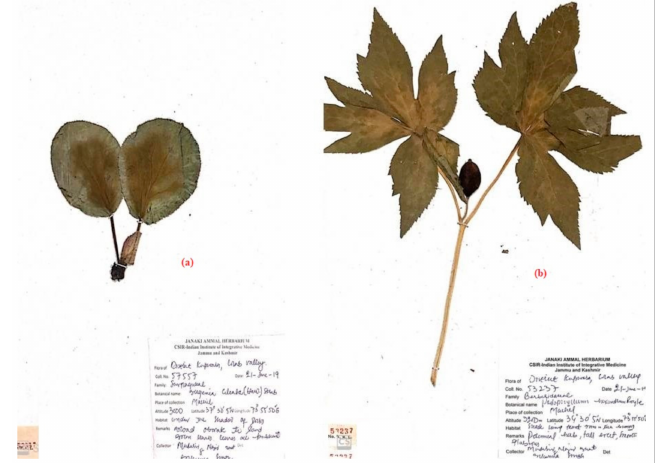
Figure 3. Snapshots of herbarium sheets prepared for a collected voucher specimen, ( a ) Bergenia ciliata (Haw.) Sternb., ( b ) Podophyllum hexandrum